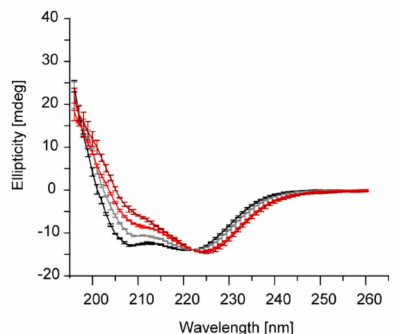
Figure 3. Acidic pH and Mg 2 + increase the 222 / 208 nm ratio. Far UV CD-spectra of IM30 measured in absence (black), in presence of Mg 2 + (gray) at pH 7.6, and of IM30 in absence (dark red) and in presence of Mg 2 + (light red) at pH 5.5. Spectra were normalized at 222 nm ( n = 3, error bars =